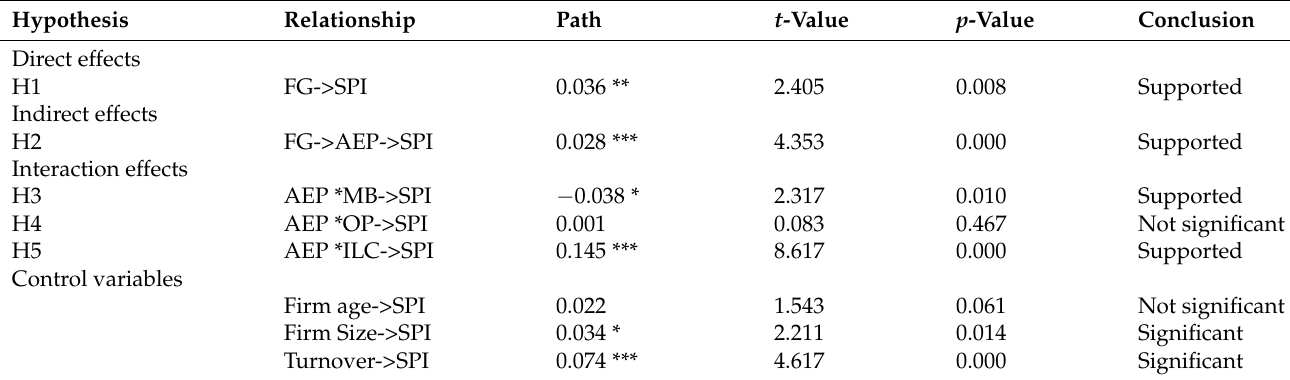
Table 5. Hypothesis